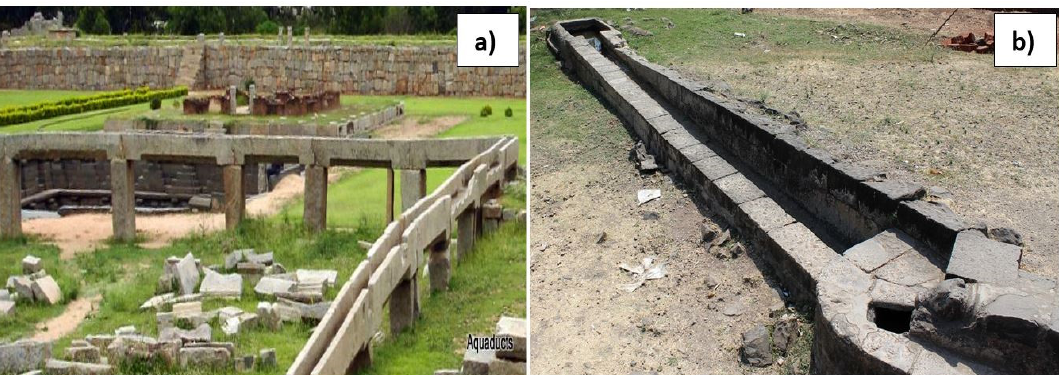
Figure 8. ( a ) Network of irrigation works and canals https://hampi.in/aqueducts-and-canals, ac- cessed on 20 July 2022; ( b ) surface drains connecting agriculture fields from stepwells of Hampi, Karnataka a UNESCO world heritage site